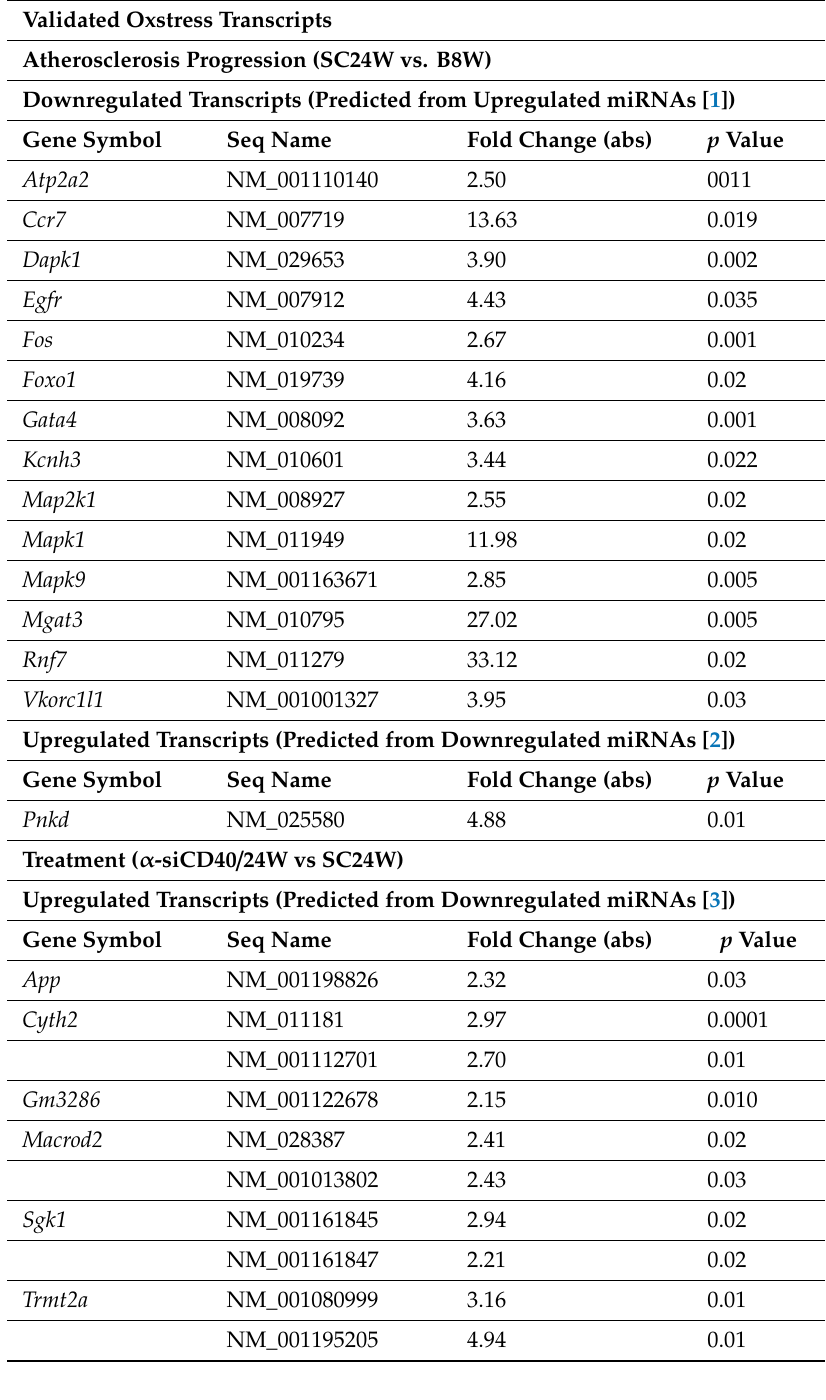
Table 1. Identity and expression of validated Oxstress transcripts. Shown are the Oxstress transcripts shown to be putative targets of the miRNAs whose expression was altered during ATHp or after treatment with the α -CD40 siRNA (as Fold Change in absolute values). Transcripts are identified by their unique GeneSymbol identifier and the specific isoform by its Seqname. Numbers between brackets refer to the groups of miRNAs of Supplementary Table S1. No downregulated transcripts predicted from upregulated miRNAs in the treatment group were